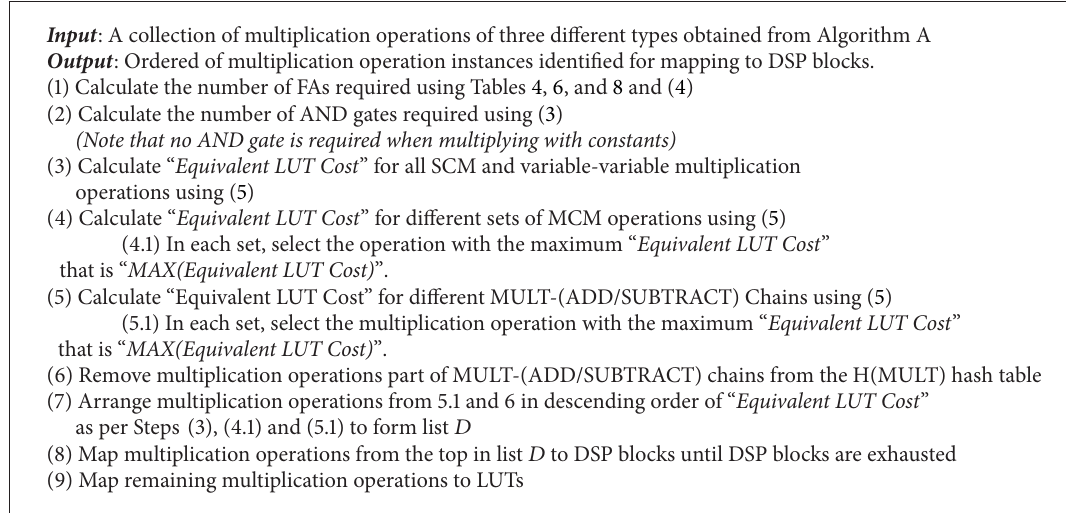
Algorithm 2: Joint comparison and selection (JCS)